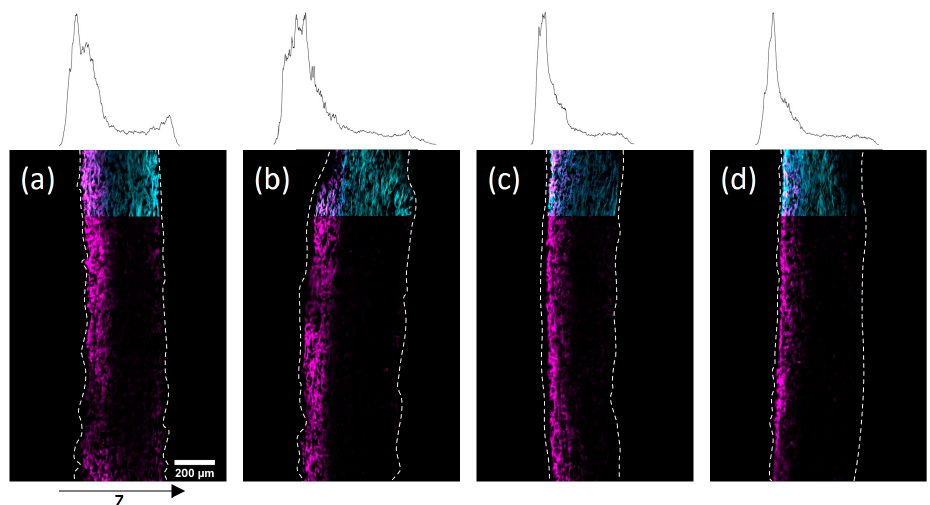
Figure 7. Cross-sections of paper samples with different grammages modified with the photo-cross- linkable copolymer dissolved in H 2 O (34 mg mL − 1 ) dried in an oven at 120 °C on Teflon-plates (150 g m − 2 ( a ); 200 g m − 2 ( b )), and dissolved in IPA (48 mg mL − 1 ) dried on Teflon-plates at r.t. (150 g m − 2 ( c ); 200 g m − 2 ( d )), acquired by fluorescence CLSM. The fibers are stained with FB (cyan color, outline continued) and the copolymer fluoresces due to the rhodamine B label (magenta). The left side of the images corresponds to the side that was facing upwards during drying and UV-excitation of samples. The z-distribution of the copolymer fluorescence is shown above each